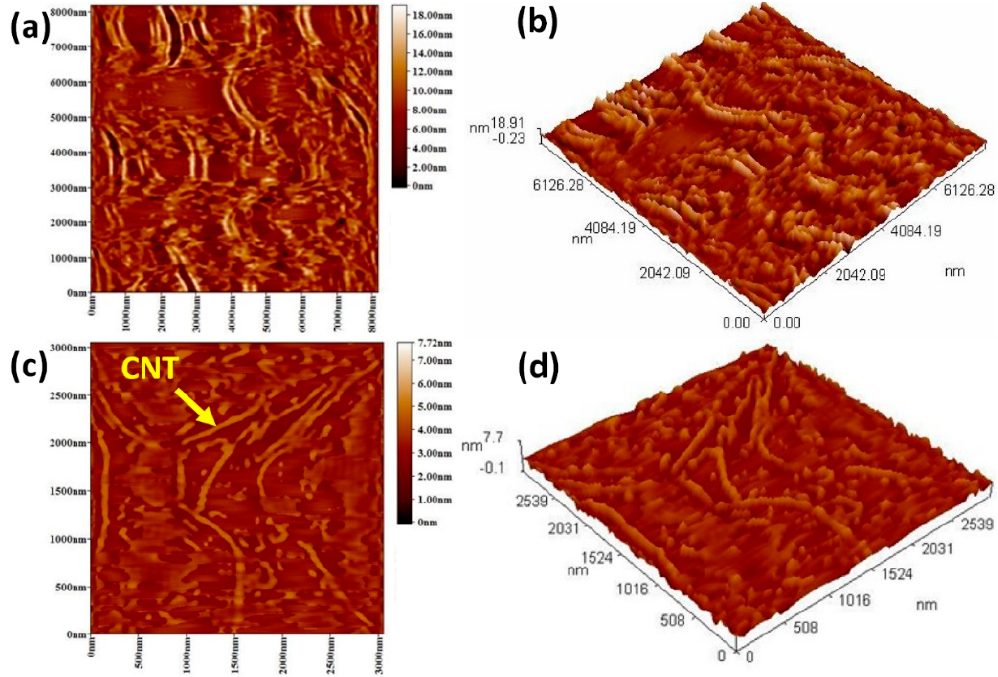
Figure 2. Atomic force microscopy (AFM) images of produced MWNTs: ( a , b ) 2-D and 3-D sections before any treatment, ( c , d ) 2-D and 3-D sections after treatment by hydrogen peroxide and acetone.